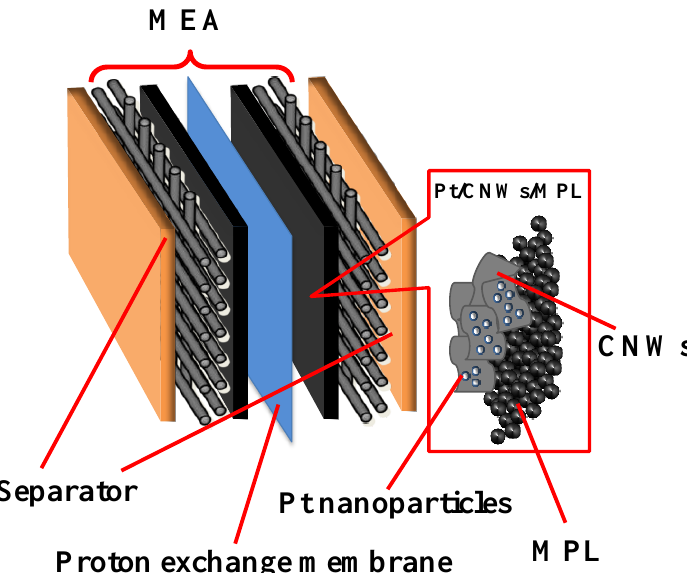
Figure 2. Schematic diagram of the single PEFC using CNWs.